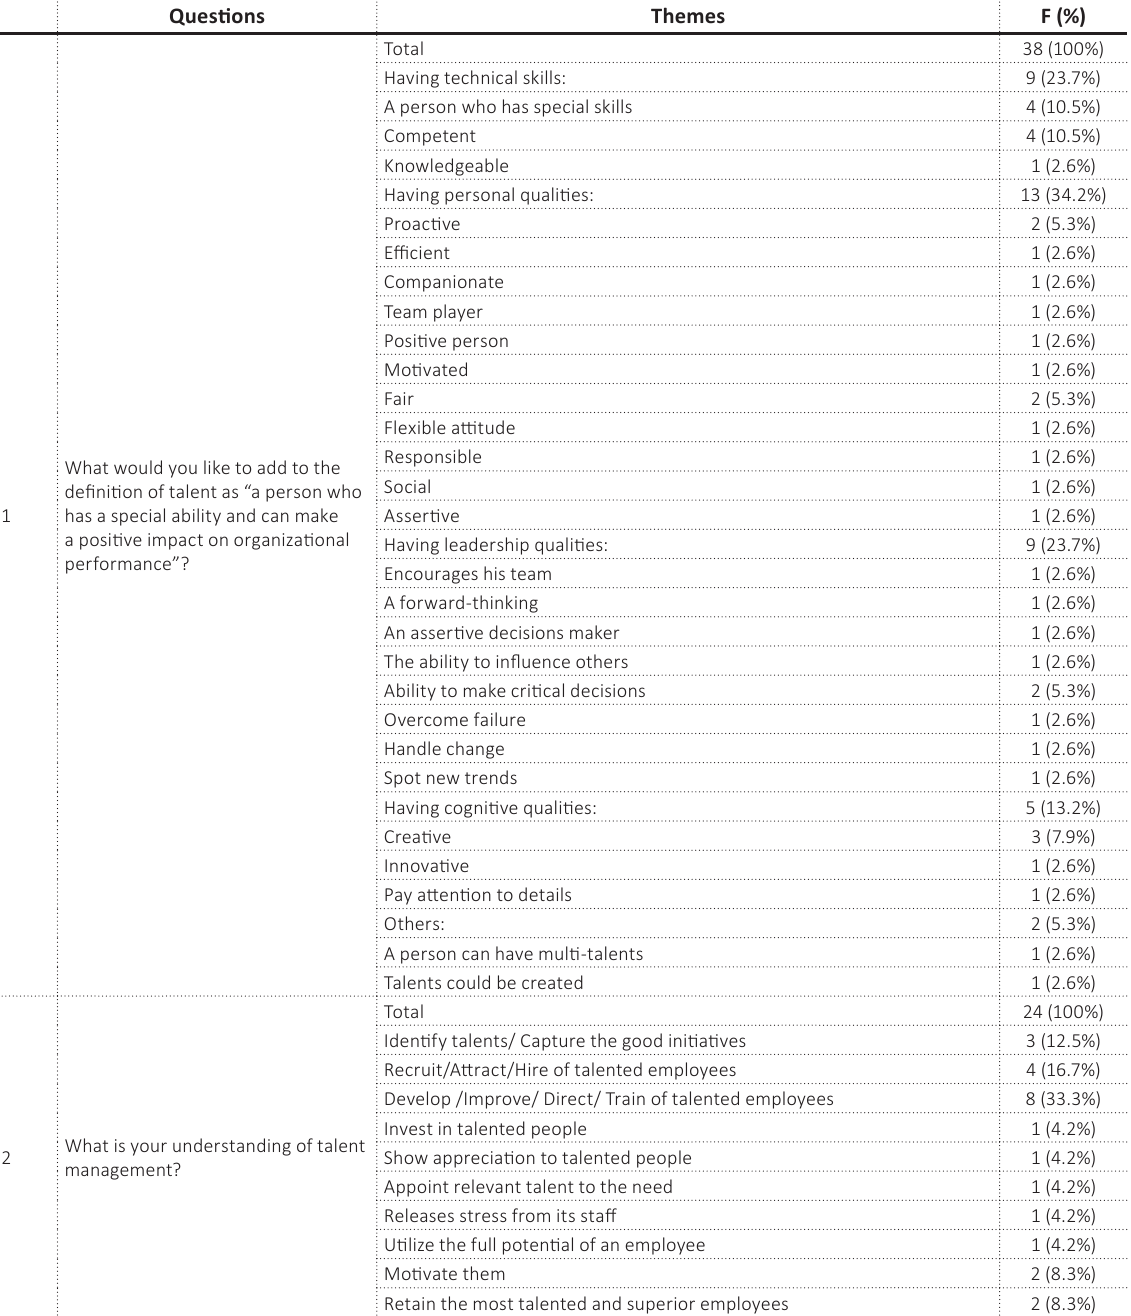
Table A1. Thematic analysis of the survey’s